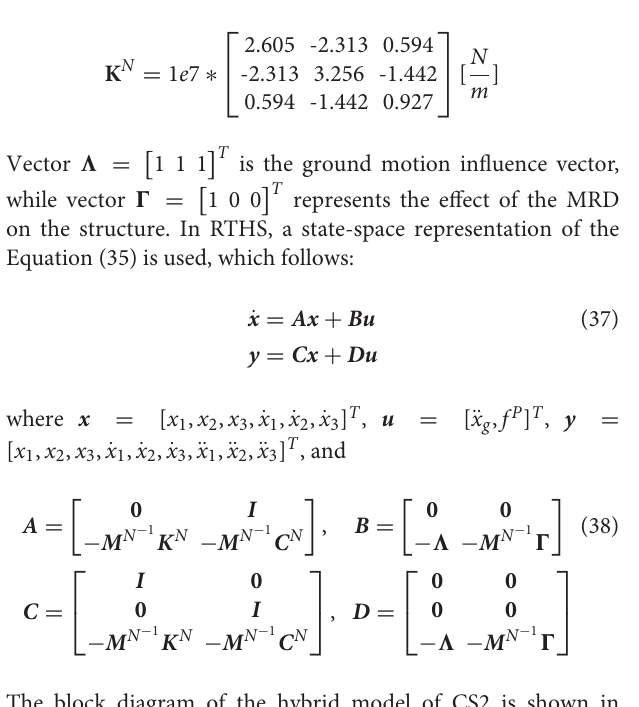
The block diagram of the hybrid model of CS2 is shown in Figure 5B . The reference signal r , in Figure 5B , corresponds to the displacement of the first story x 1 . Respectively, ˙ r = ˙ x 1 . RTHS is conducted in displacement control, as in CS1. The ground motion applied to the hybrid model is the same as in CS1, a historical acceleration record from the El Centro 1940 earthquake downscaled by 0.4. As in CS1, apart from the additive disturbance described in Equation (2), additional white noise v is added in the calculated force from MRD f P , which represents measurement noise from the load cell. The load cell measurement noise is modeled with a standard Gaussian distribution, generated at the same frequency as the sampling of RTHS and amplified by 0.15 N , which approximately equals to 0.01% of the load cell full span. The sampling frequency of RTHS was set to f RTHS = 4, 096